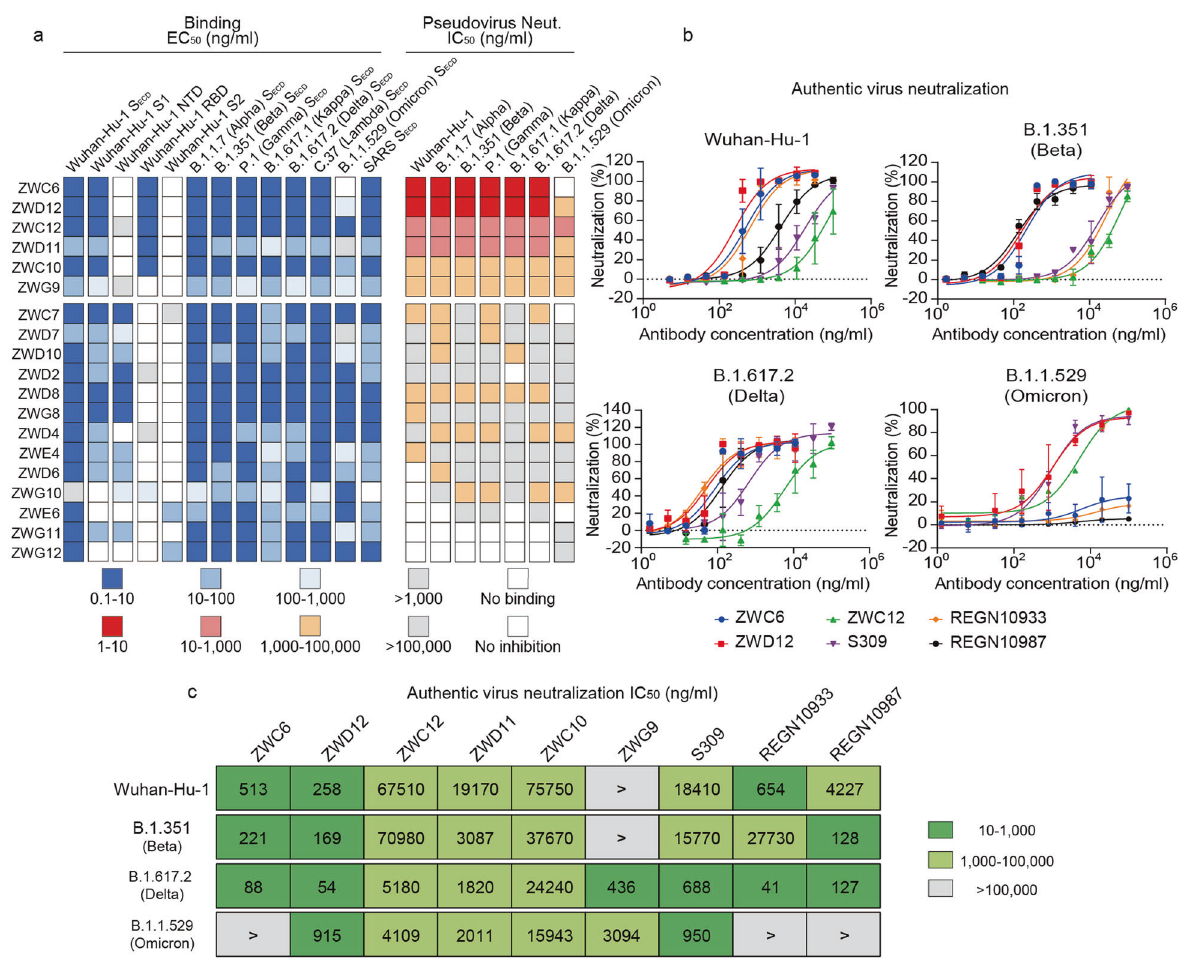
Fig. 2 Neutralization of pseudotyped and authentic SARS-CoV-2 variants. a Heatmap showing the binding EC 50 values for S fragments of SARS-CoV-2 variants and neutralization IC 50 values of pseudotyped SARS-CoV-2 variants. b Neutralization curves of authentic SARS-CoV-2 variants by ZWC6, ZWD12, ZWC12, and FDA-approved mAbs. The data are representative of one of at least two independent experiments and are presented as the mean ± SD. c IC 50 values of authentic virus-neutralizing mAbs. ND, not